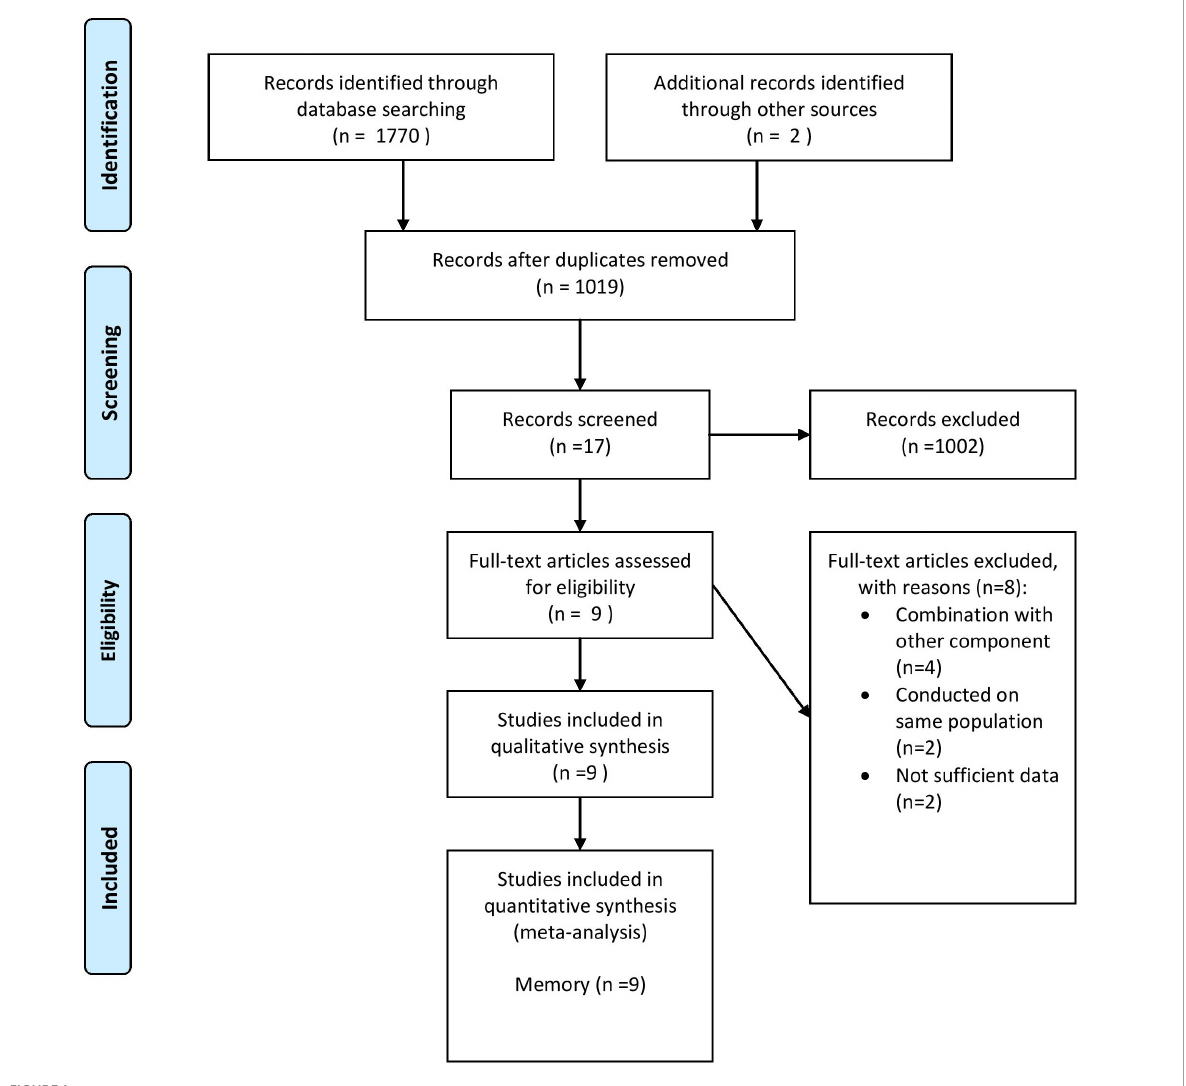
FIGURE1 Flow diagram of study selection. Adopted from Moher et al.